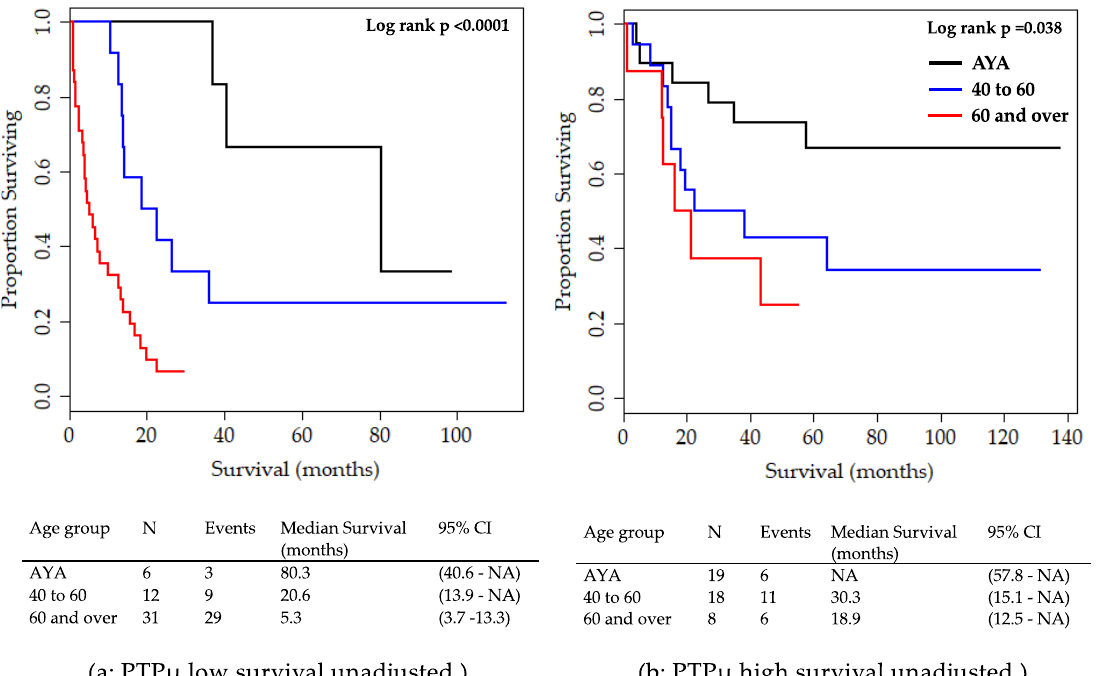
Figure 4. Kaplan Meier survival plots for overall survival by PTP µ low versus high staining and age at diagnosis for all glioma patients. ( a ) Unadjusted survival for PTP µ low patients. ( b ) Unadjusted survival for PTP µ high patients.